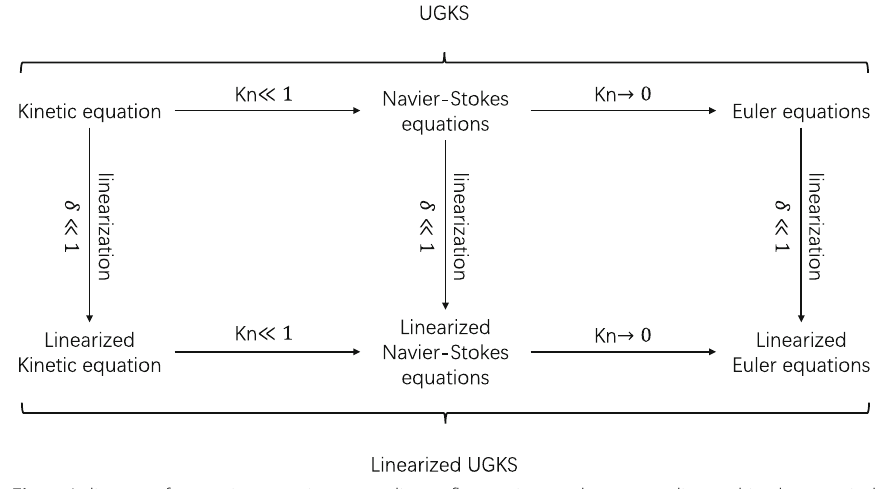
Fig. 1 A diagram of governing equations according to flow regime, and corresponding multiscale numerical